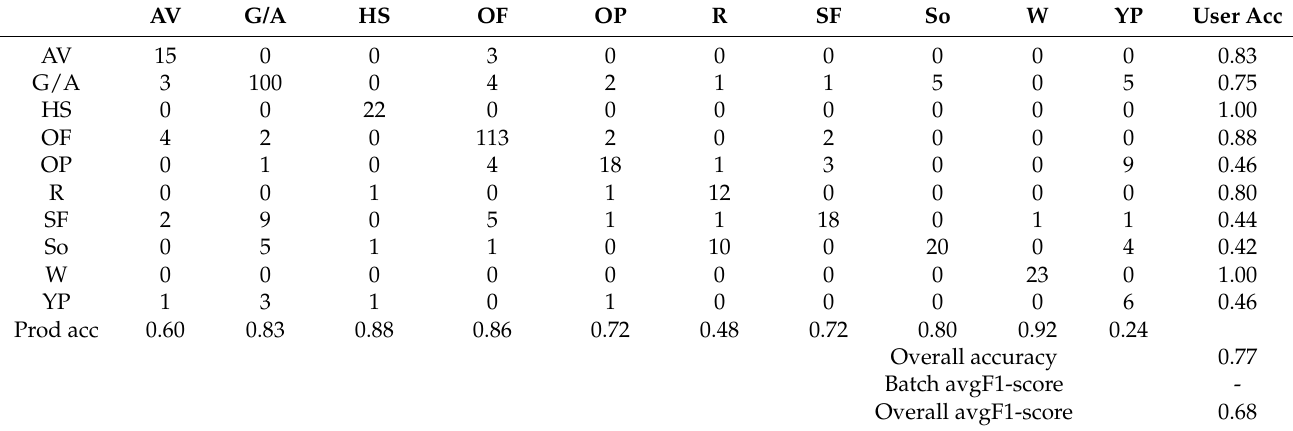
Table A5. Confusion matrix resulting from the accuracy assessment procedure of the complete study area LULC classification obtained with the MS + SAR U-net. Rows show predicted classes while columns, ground truth classes. LULC abbreviations: AV, aquatic vegetation; G/A, grasslands/agriculture; HS, human settlements; OF, old-growth forests; OP, old-growth plantations; R, roads; SF, secondary forest; So, soil, W, water; YP, young plantations. User acc stands for user’s accuracy, while Prod acc for producer’s